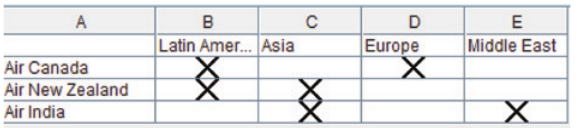
Figure 1: Formal Context Showing Airlines and their Sector of Operations.